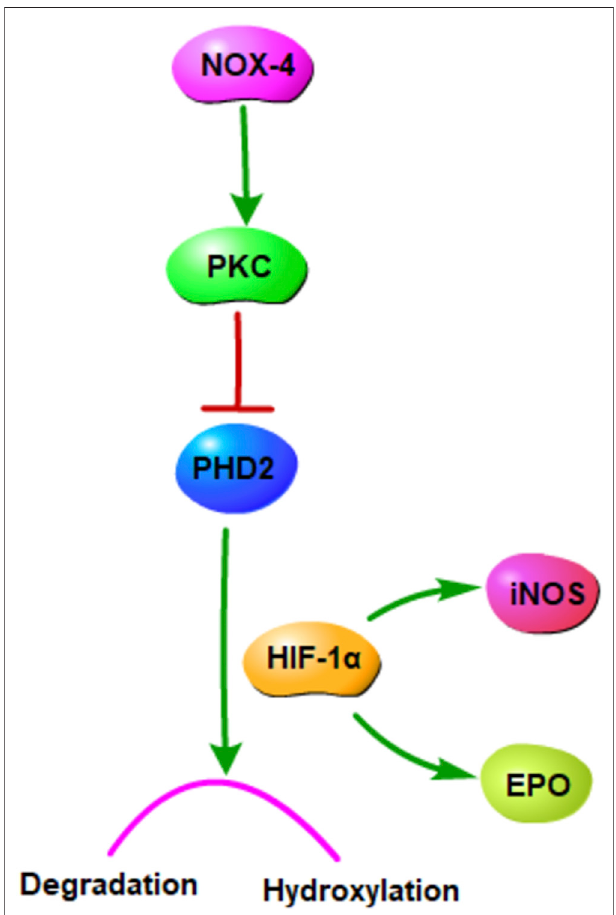
FIGURE 9 | ThePKC/HIF-1 α signalingpathwayinthecondition ofhypoxia.